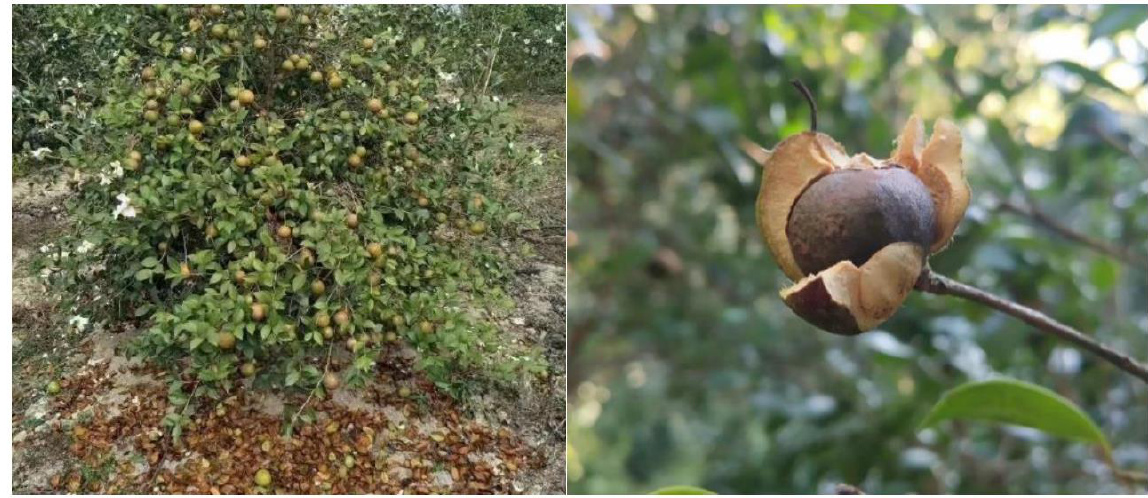
Figure 1. High-yield Camellia oleifera trees growing in hilly and mountainous areas.